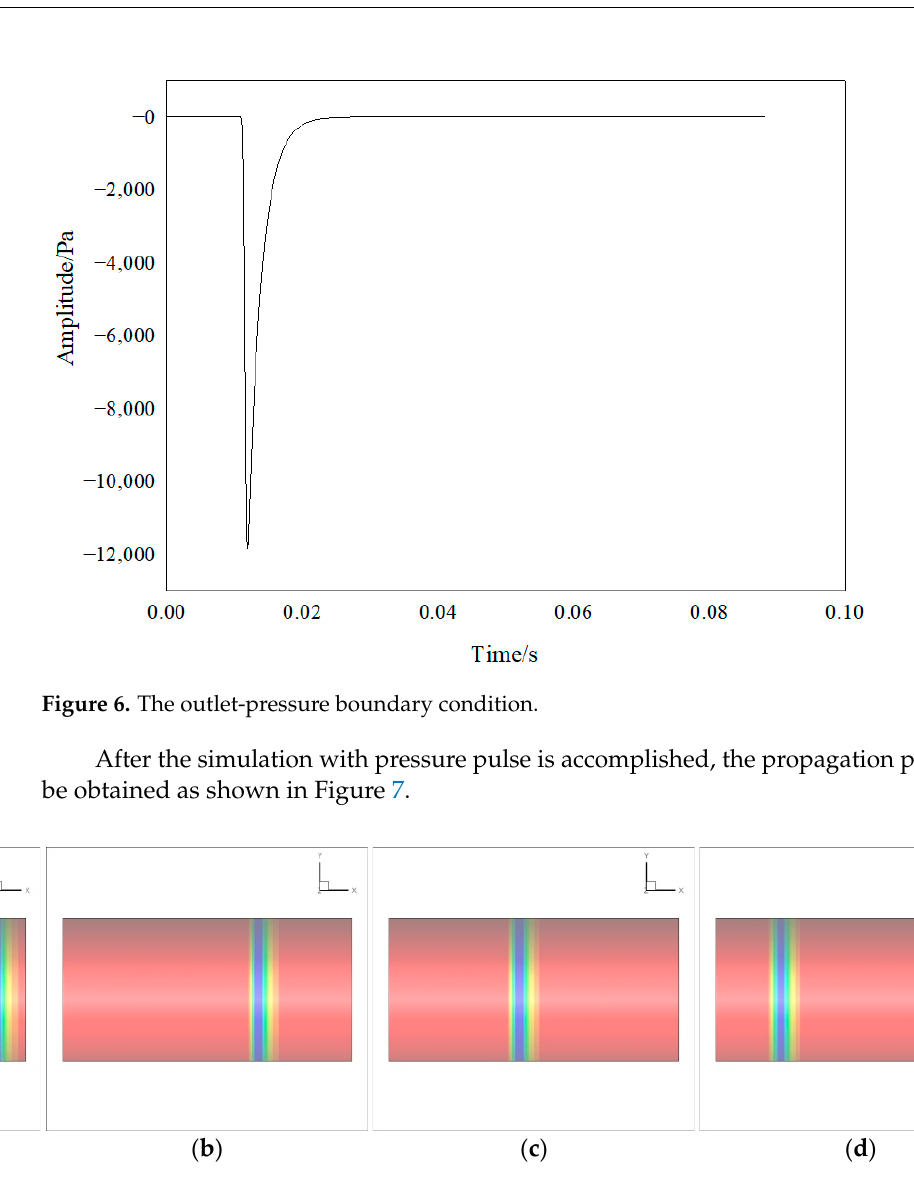
Figure 7. Pressure distribution when the pulse propagates in the pipe when acoustic waves propagate upstream (blue represents the amplitude): ( a ) 0.02 s, ( b ) 0.04 s, ( c ) 0.06 s, ( d ) 0.08 s. The pressure is stable before 0.01 s, and there is a negative pressure zone in the pipe with the input of pressure pulse. The negative pressure zone shows the same laws with the one of the acoustic waves propagating downstream. The acoustic pressure amplitude variations are shown in Figure 8.